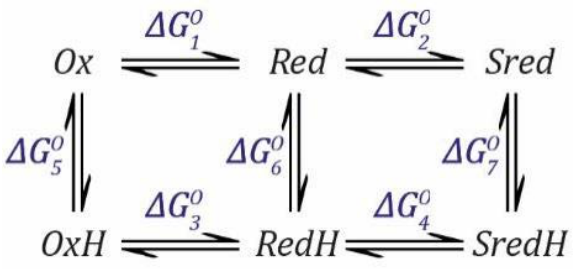
Scheme 4. Scheme showing the free energy changes for the reactions in a simple model for the [FeFe] hydrogenase. The oxidised and deprotonated species Ox can be reduced to Red with a free energy change ∆ G 1 . Red can be further reduced to Sred with a free energy change ∆ G 2 . The oxidised protonated species OxH can be reduced to give RedH with a free energy change ∆ G 3 . RedH can be further reduced to SredH with a free energy change ∆ G 4 . OxH, RedH , and SredH can be deprotonated to Ox , Red , and Sred , respectively, with free energy changes ∆ G 5 , ∆ G 6 , and ∆ G 7 , respectively ( − ∆ G 5 , ∆ G − ∆ G 6 , and – 7 for the respective protonation